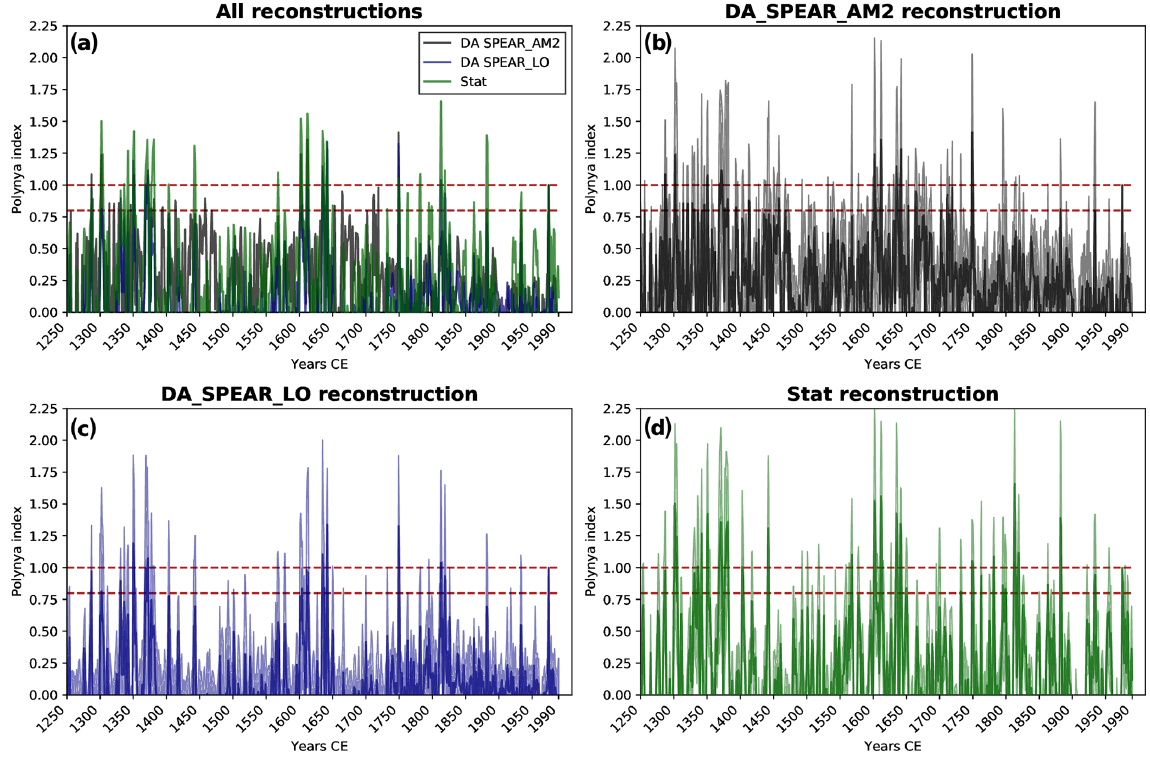
Figure 7. Same as Fig. 6 but for the years from 1250 to